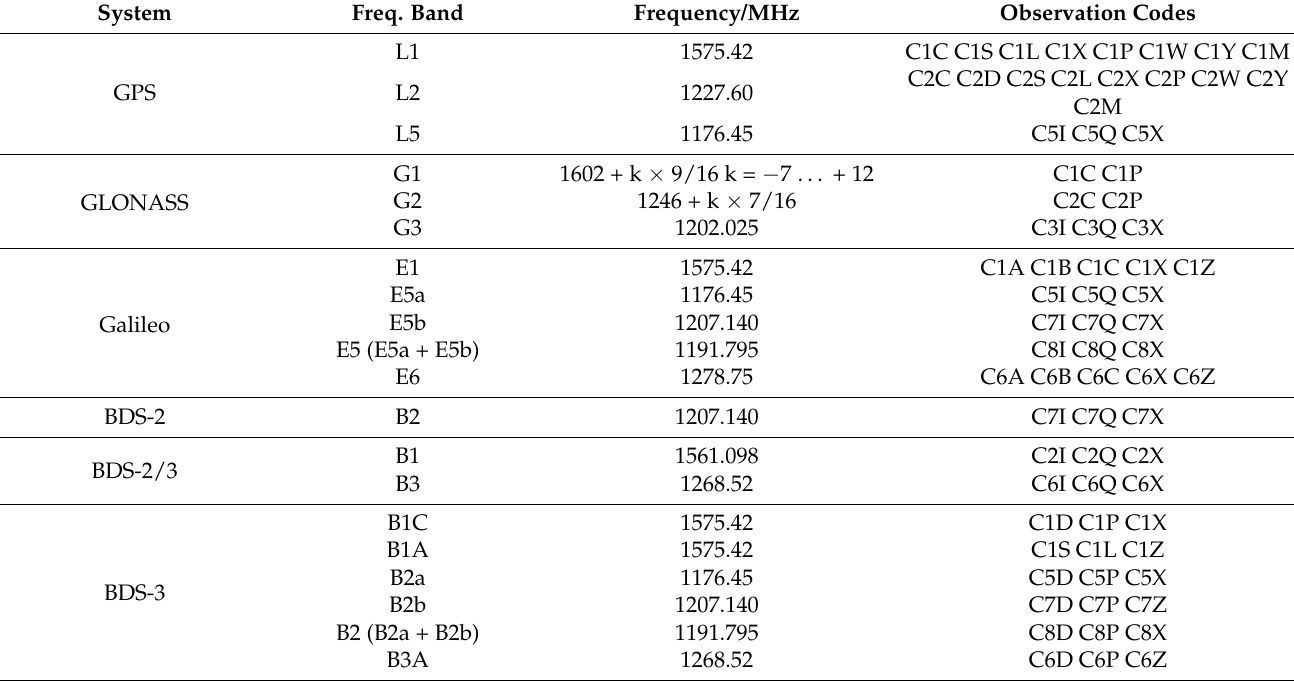
Table 2. Multi-frequency multi-GNSS signals